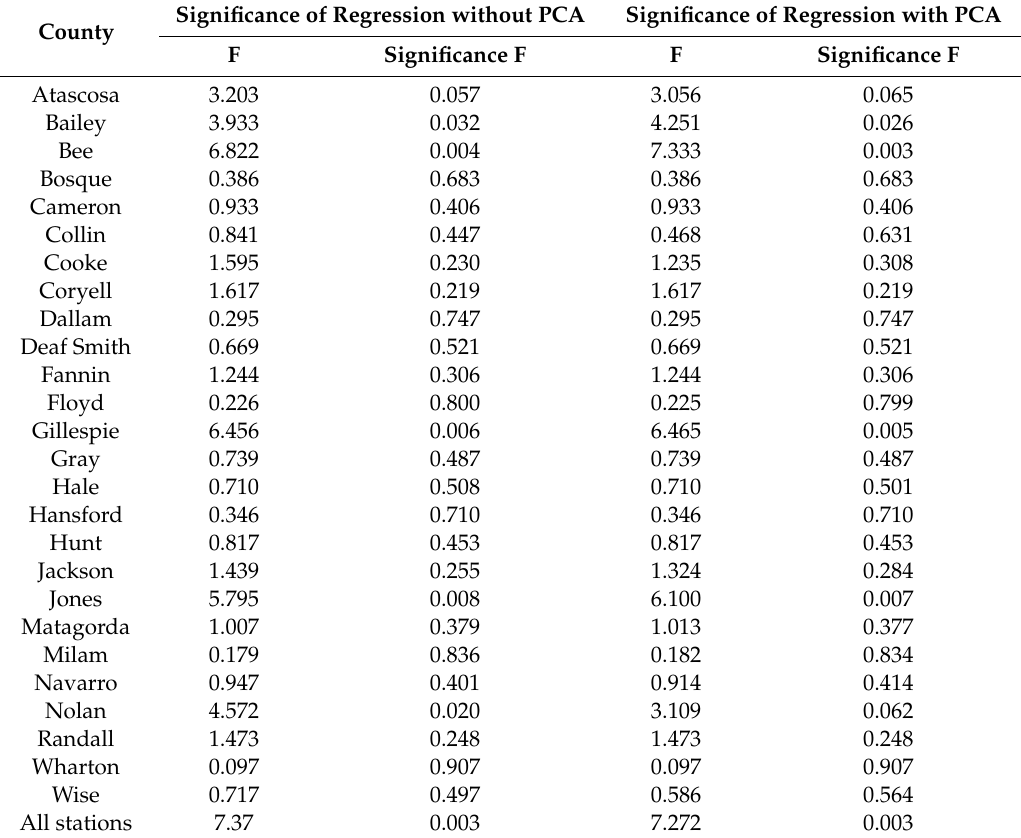
Table 6. Relevance of regression relationships.